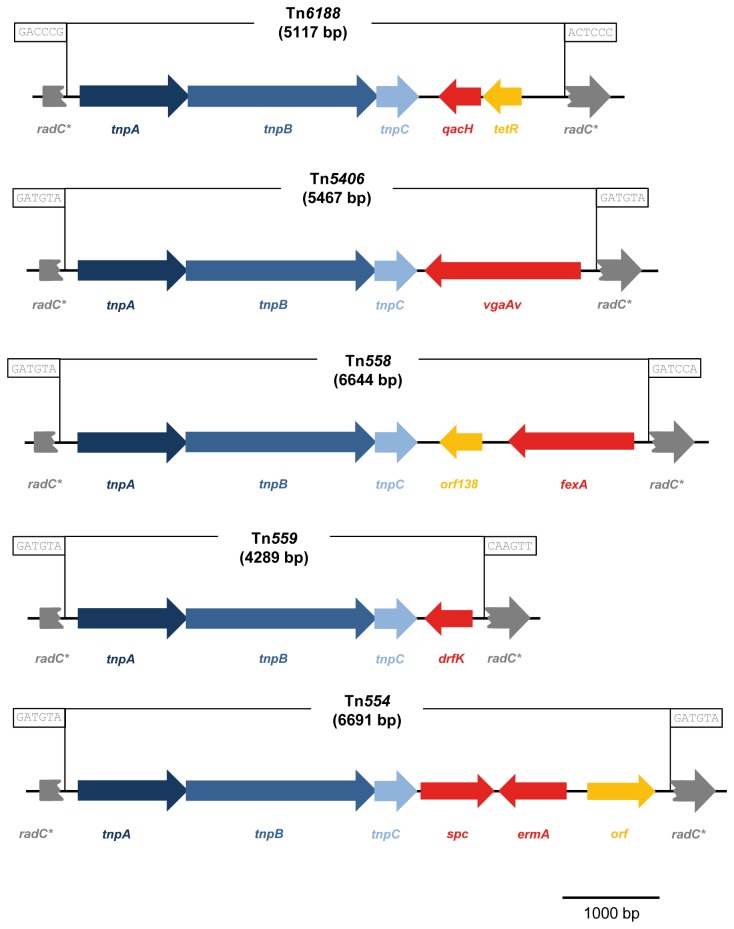
Organization of the L. monocytogenes transposon Tn6188 and comparison with other related transposons Tn554 (X03216), Tn5406 (AF186237), Tn558 (AJ715531), Tn559 (FN677369).The transposase genes tnpABC are shown in dark blue, blue and light blue, respectively. Effector proteins conferring antimicrobial resistance are shown in red; proteins with other or unknown function are shown in orange. The 6 bp nucleotide sequences at the transposon junctions are shown in boxes. The disrupted radC genes are indicated by an asterisk.